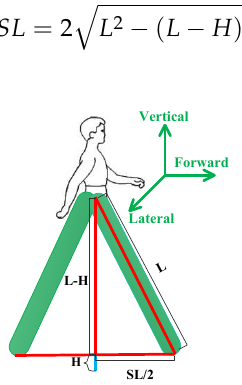
Figure 2. Step length